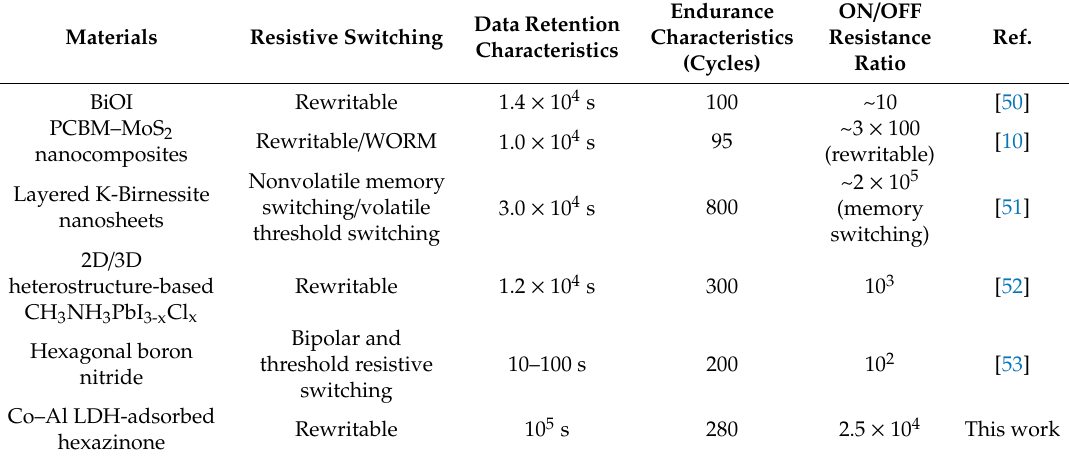
Table 1. Performance comparison of resistive switching memory based on 2D materials.